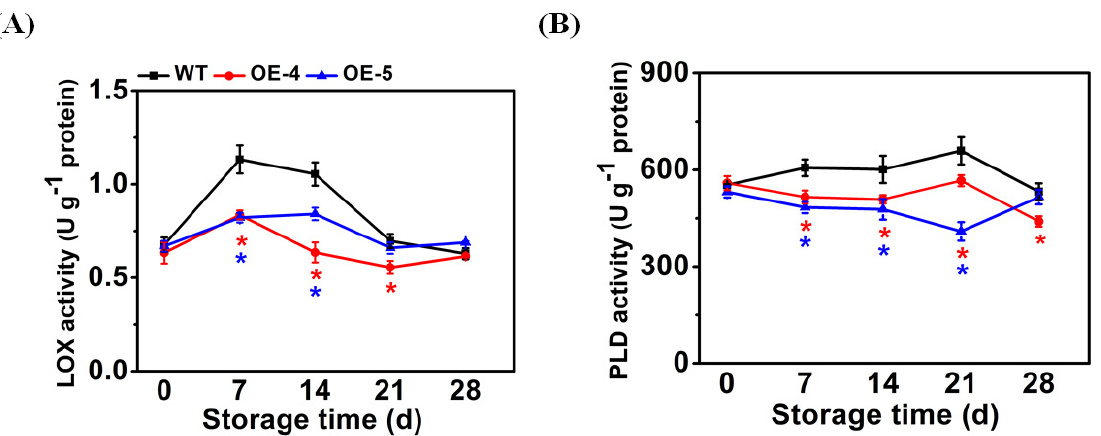
Figure 4. SlCYP90B3 overexpression suppressed the activities of ( A ) LOX and ( B ) PLD in tomato fruits during 28 days of cold storage. Each data point is mean ± SE ( n = 3). fruits during 28 days of cold storage. Each data point is mean ± SE ( n =